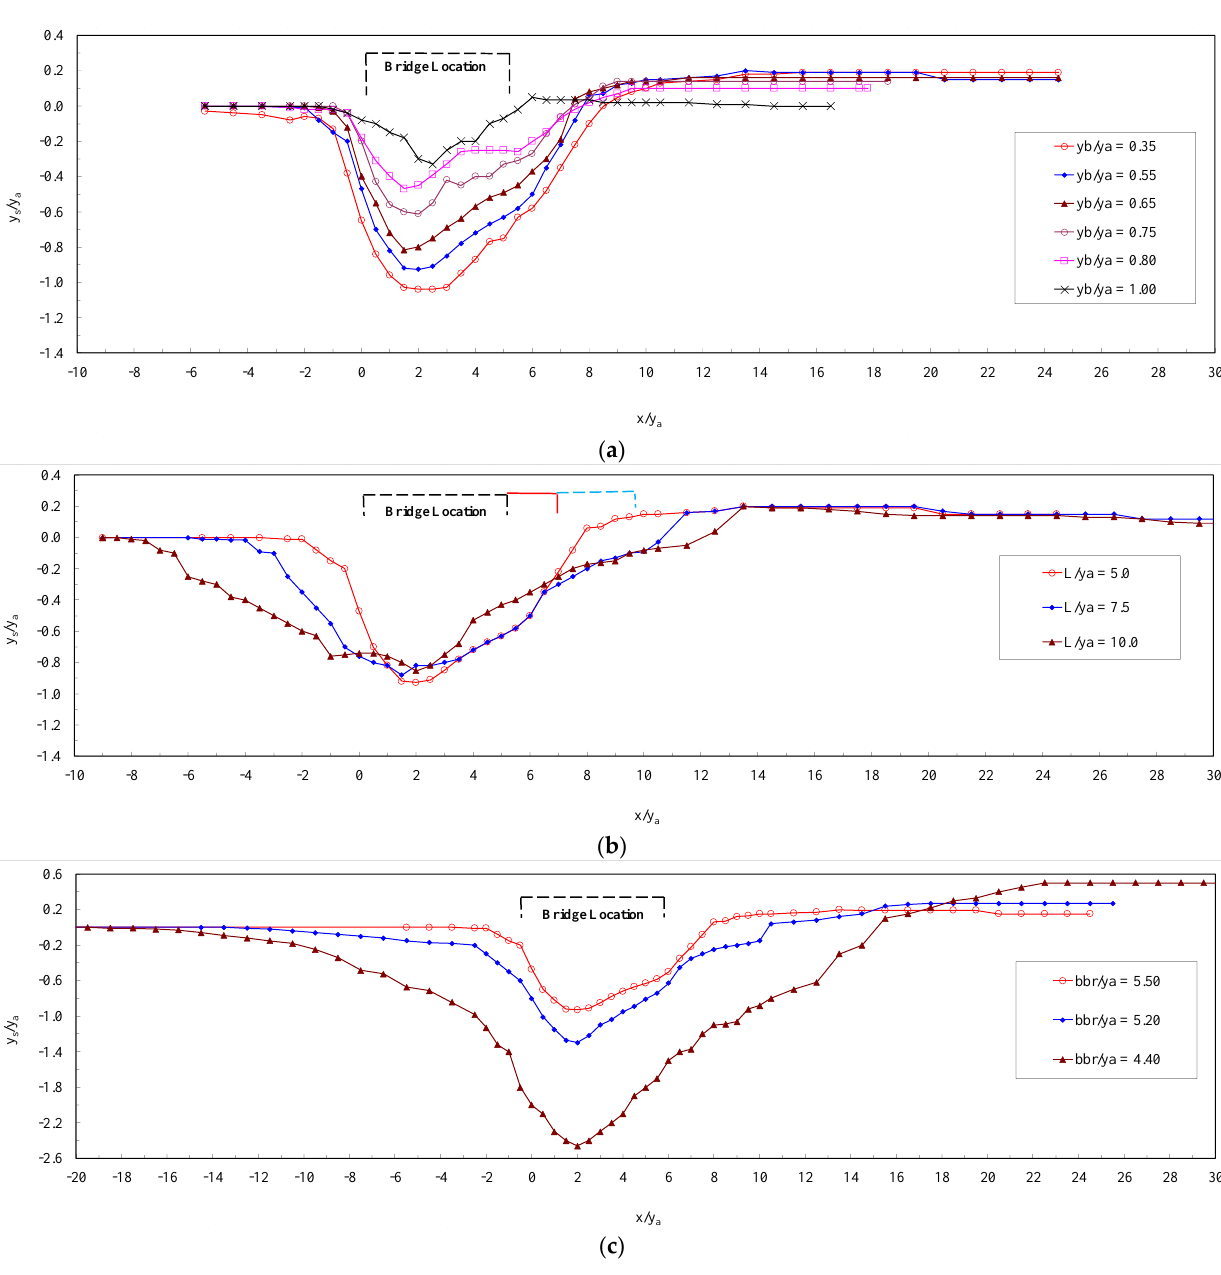
Figure 7. Relative scour depth y s / y a in the nondimensional streamwise distance x / y a for F ∗ a = 0.236 and for: ( a ) different relative bridge opening y b /y a ; ( b ) different relative bridge lengths L / y a and y b /y a = 0.55; and ( c ) different relative bridge widths ( b br / y a ) and y b /y a =